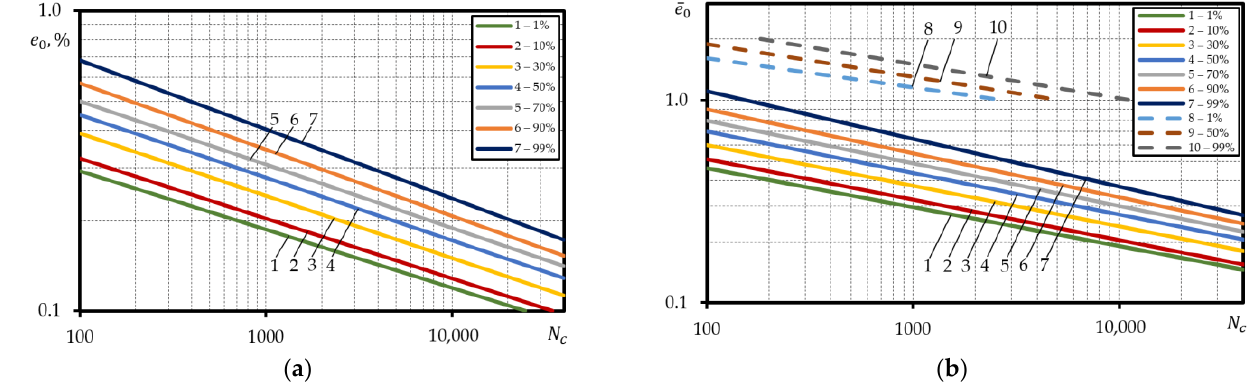
Figure 10. Probabilistic low-cycle fatigue curves under strain-controlled loading for aluminium al- loy D16T1 built using: the absolute coordinates ( a ); the relative coordinates ( b ); straight lines — calculated, dashed lines — experiment.